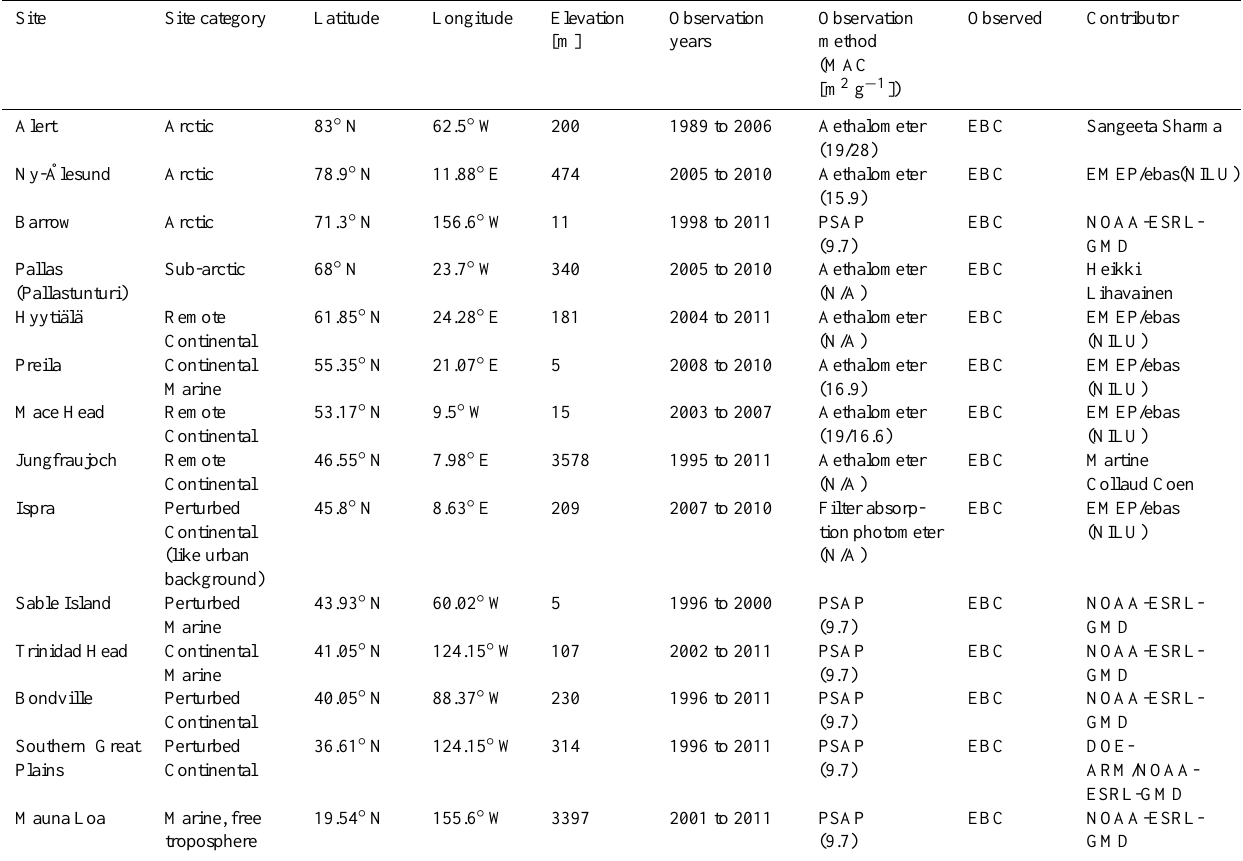
Table 4. List of observation sites for black carbon surface mass concentrations. MAC (mass absorption coefficient, a unit of m 2 per gram) value is presented in the parentheses below the observation method when available (see Sect. 4.2 for